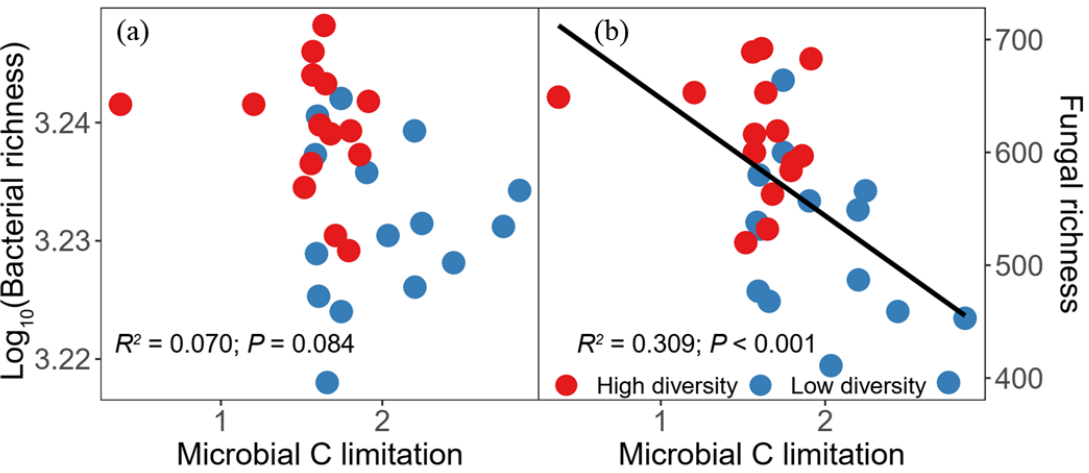
Figure 4. Relationships between soil microbial carbon (C) limitation and bacterial richness ( a ) and fungal richness ( b ). The black lines represent the fitted ordinary least squares (OLS) linear regressions. Red circles represent high plant diversity, while blue ones indicate low plant diversity.